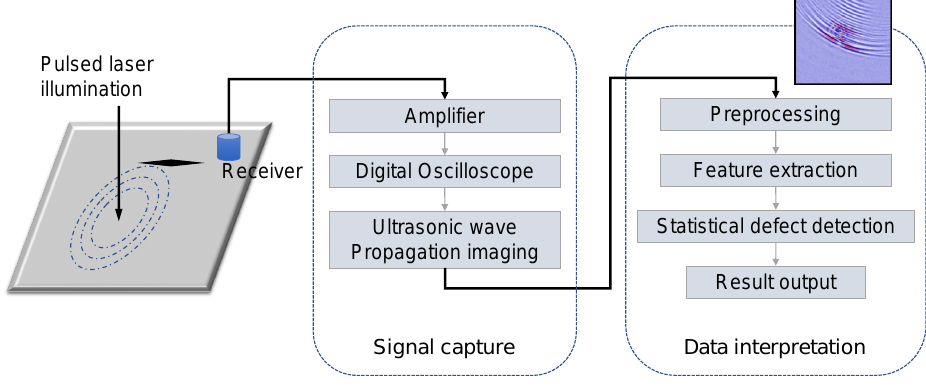
Figure 1. The general processing flow of computerized ultrasonic imaging